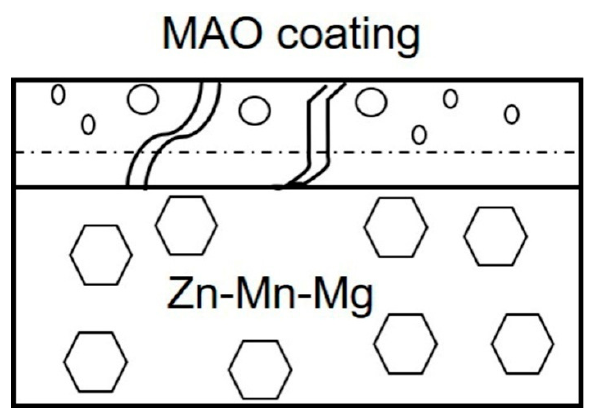
Figure 8. The schematic illustration of Zn-Mn-Mg alloys fabricated by the MAO with different NaF concentrations from 0.5 g/L to 2.5 g/L.